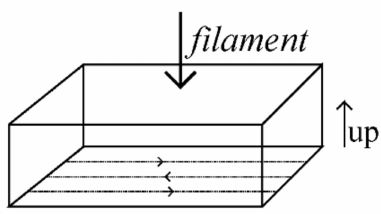
Figure 3. Building orientation of lattice